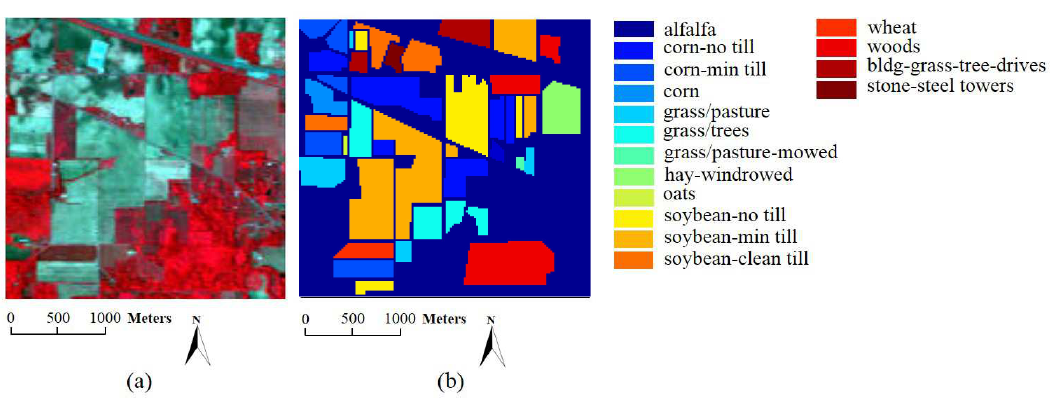
Figure 4. Indian Pines data. ( a ) Three band false color composite and ( b ) ground truth data with 16